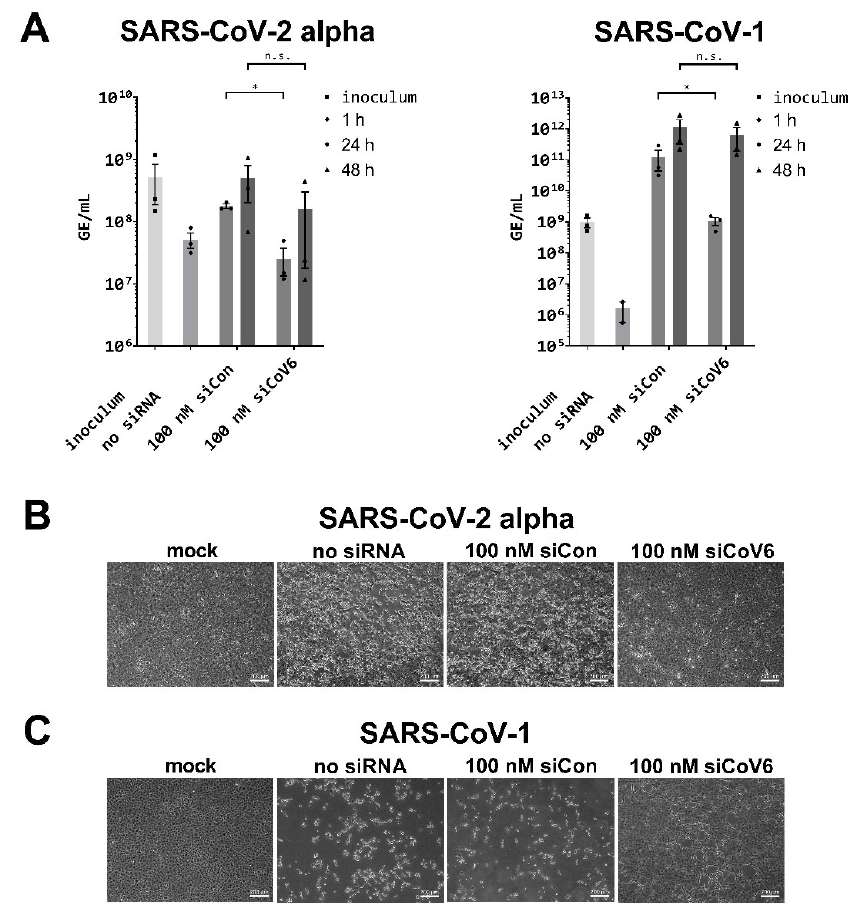
Figure 4. Inhibition of SARS ‐ CoV ‐ 2 alpha and SARS ‐ CoV ‐ 1 replication by siCoV6. ( A ) The replication of SARS ‐ CoV ‐ 2 alpha (BetaCoV/Germany/ChVir21652/2020) and SARS ‐ CoV ‐ 1 (recombinant SARS ‐ CoV ‐ 1, GenBank: AY310120.1) was investigated by quantitative RT ‐ PCR in Vero E6 cells. Vero E6 cells were transfected with 100 nM siCoV6 or 100 nM siCon and infected 24 h after transfection with SARS ‐ CoV ‐ 2 alpha or SARS ‐ CoV ‐ 1 at a MOI of 0.01. Genome equivalents per mL (GE/mL) were determined by quantitative RT ‐ PCR as described in Figure 3. The mean ± SEM of three independent experiments is shown. The statistical significance was determined by Student’s t ‐ test; * p < 0.05. ( B,C ) Cell morphology observation. Cells were fixed 48 h after infection with SARS ‐ CoV ‐ 2 alpha or SARS ‐ CoV ‐ 1 and the cytopathic effect (CPE) of viral infection was documented by transmitted light microscopy. Representative data from three independent experiments are shown. Scale bar: 200 μ m.